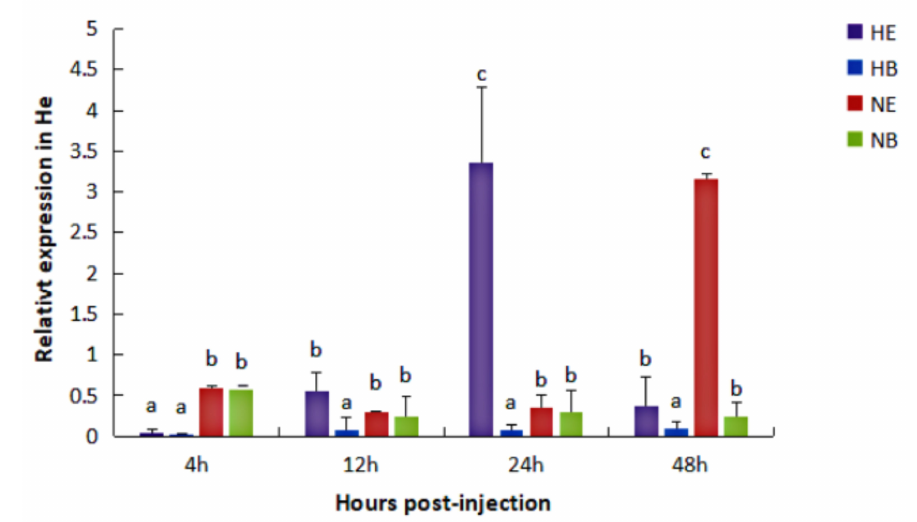
Figure 3. Expression level of HdHSP70 in He was detected by qRT-PCR. Abalones were maintained for 96 h at increased temperature (30 ◦ C) as thermal stress condition, after 96 h they were injected with 50 µ L of live V. parahaemolyticus (1.1 × 10 8 cfu/mL) (HE) or injected with 50 µ L of 0.9% NaCl (HB); Abalones were maintained for 96 h at normal temperature (25 ◦ C), after 96 h they were injected with 50 µ L of live V. parahaemolyticus (1.1 × 10 8 cfu/mL) (NE) or injected with 50 µ L of 0.9% NaCl (NB); Samples were collected at 4, 12, 24 and 48 h after injection. β -actin was selected as a reference gene. Values are means ± SD of biological replicates ( n = 6). The different letters (a, b, and c) on the error bars represent significant difference ( p < 0.05) between challenged and control group. HE: thermal stress and injected V. parahaemolyticus , HB: thermal stress and injected NaCl. NE: normal condition and injected V. parahaemolyticus , NB: normal condition and injected NaCl. He: